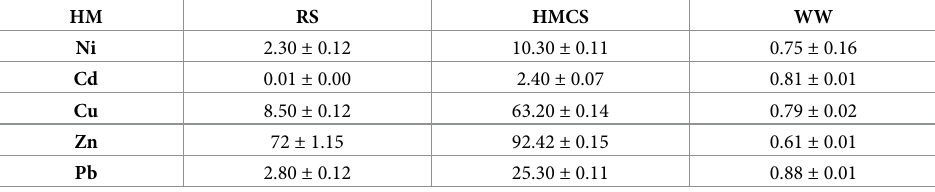
Table 1. Heavy metals concentration in contaminated soil as well as reference soil (mgkg -1 ) and polluted water samples (mgL -1 ).